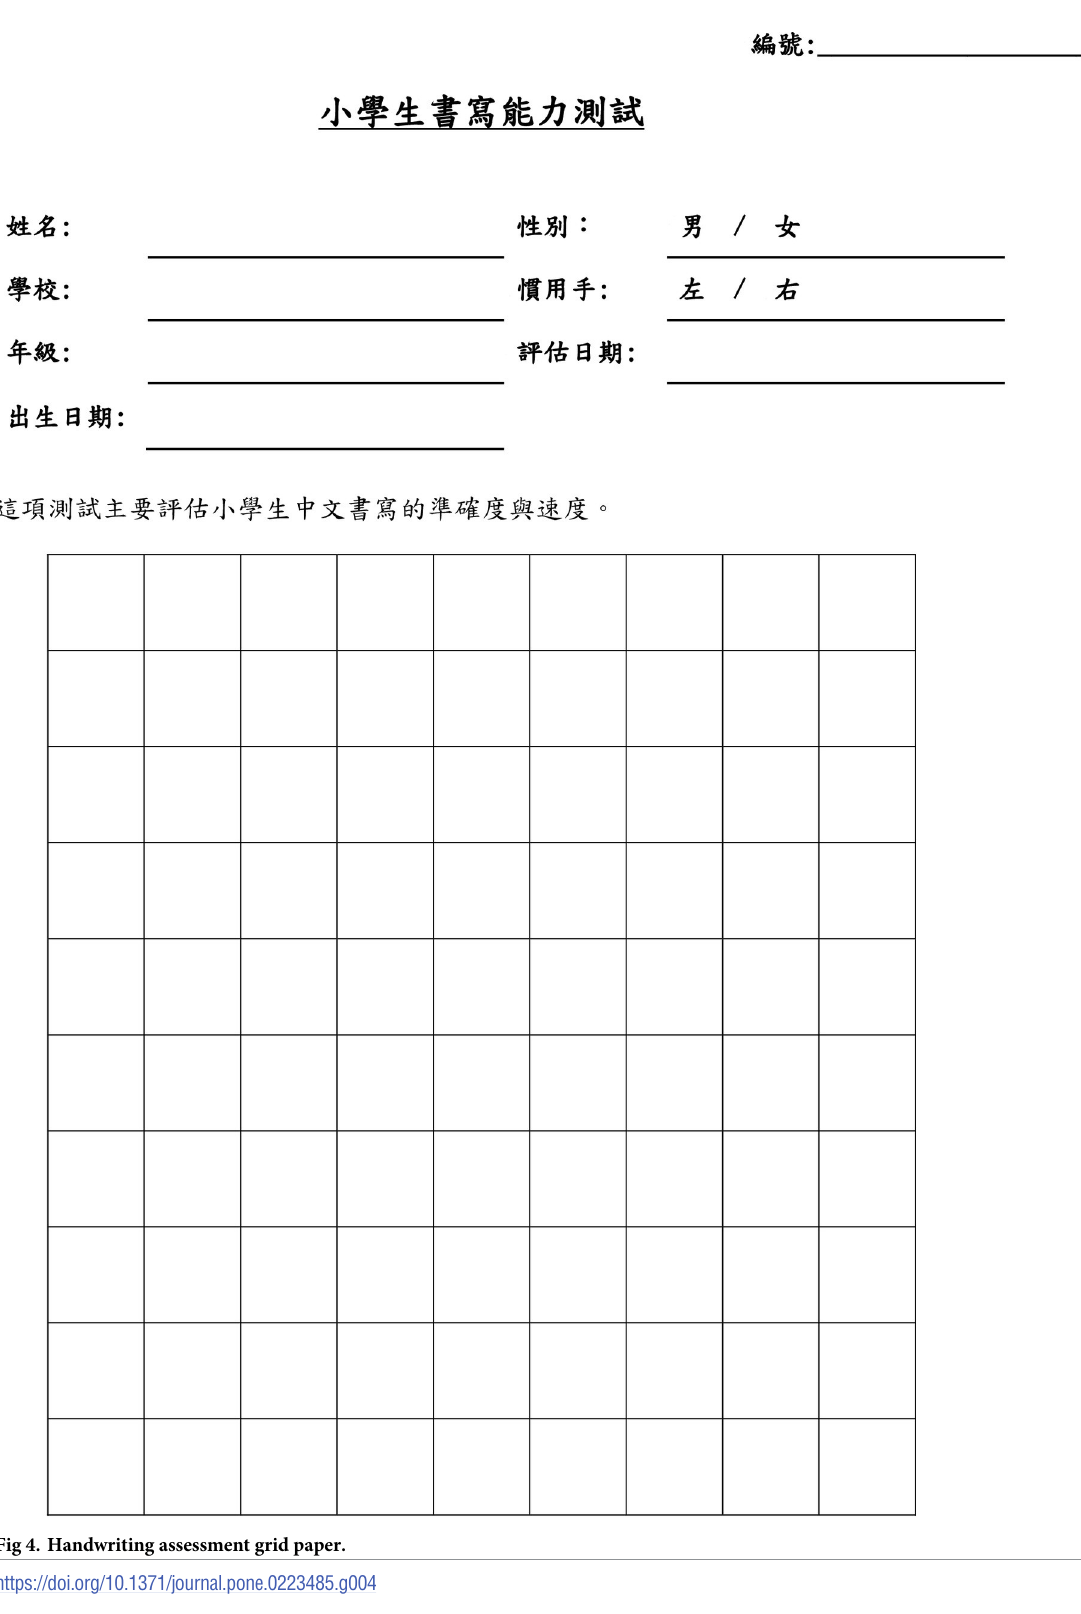
Fig 4. Handwriting assessment grid